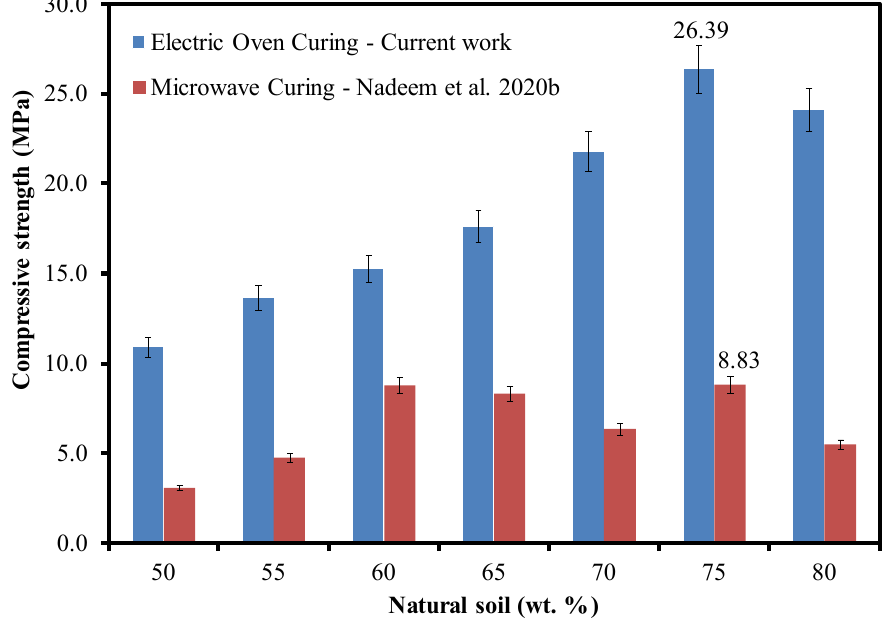
Figure 9. Comparison of compressive strengths obtained through electric oven and microwave radiation curing as a function of NS wt. fractions [8].